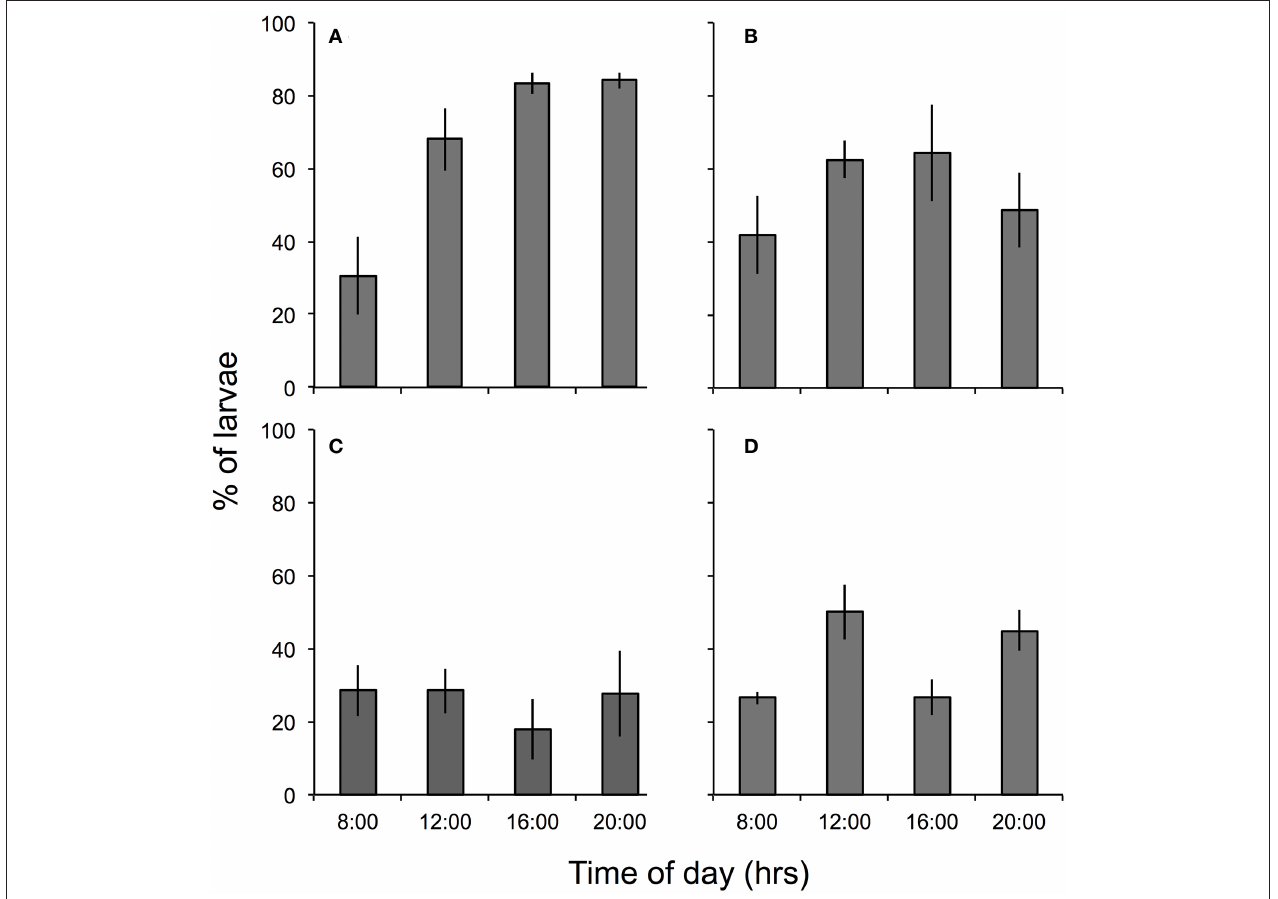
FIGURE 2 | Percent (mean ± SE, n = 4) of P. damicornis larvae in the top (0–21cm) of tubes filled with seawater at: (A) ambient ( ∼ 400 µ atm) pCO 2 , 0.3-m MD, (B) high ( ∼ 1,000 µ atm) pCO 2 , 0.3-m MD, (C) ambient pCO 2 , 3.3-m MD, and (D) high pCO 2 , 3.3-m MD. Larval position was scored every 4h in the first 12h following initiation of treatment conditions at